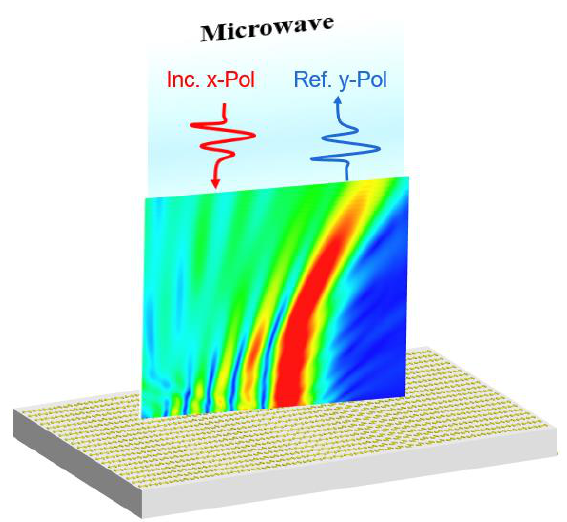
Figure 1. Conceptual diagram of an Airy beam generator using metasurfaces design in reflective geometry.